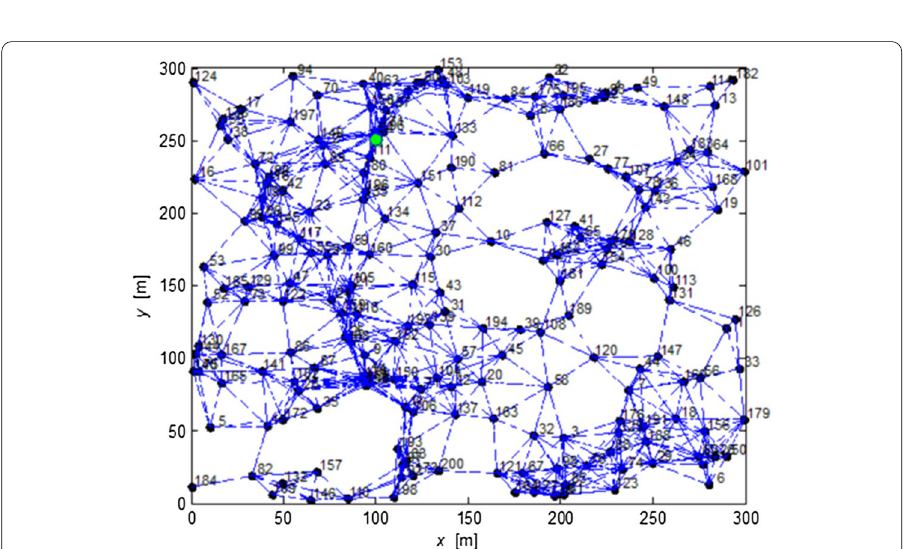
Fig. 5 WSN with 200 nodes and destination at location